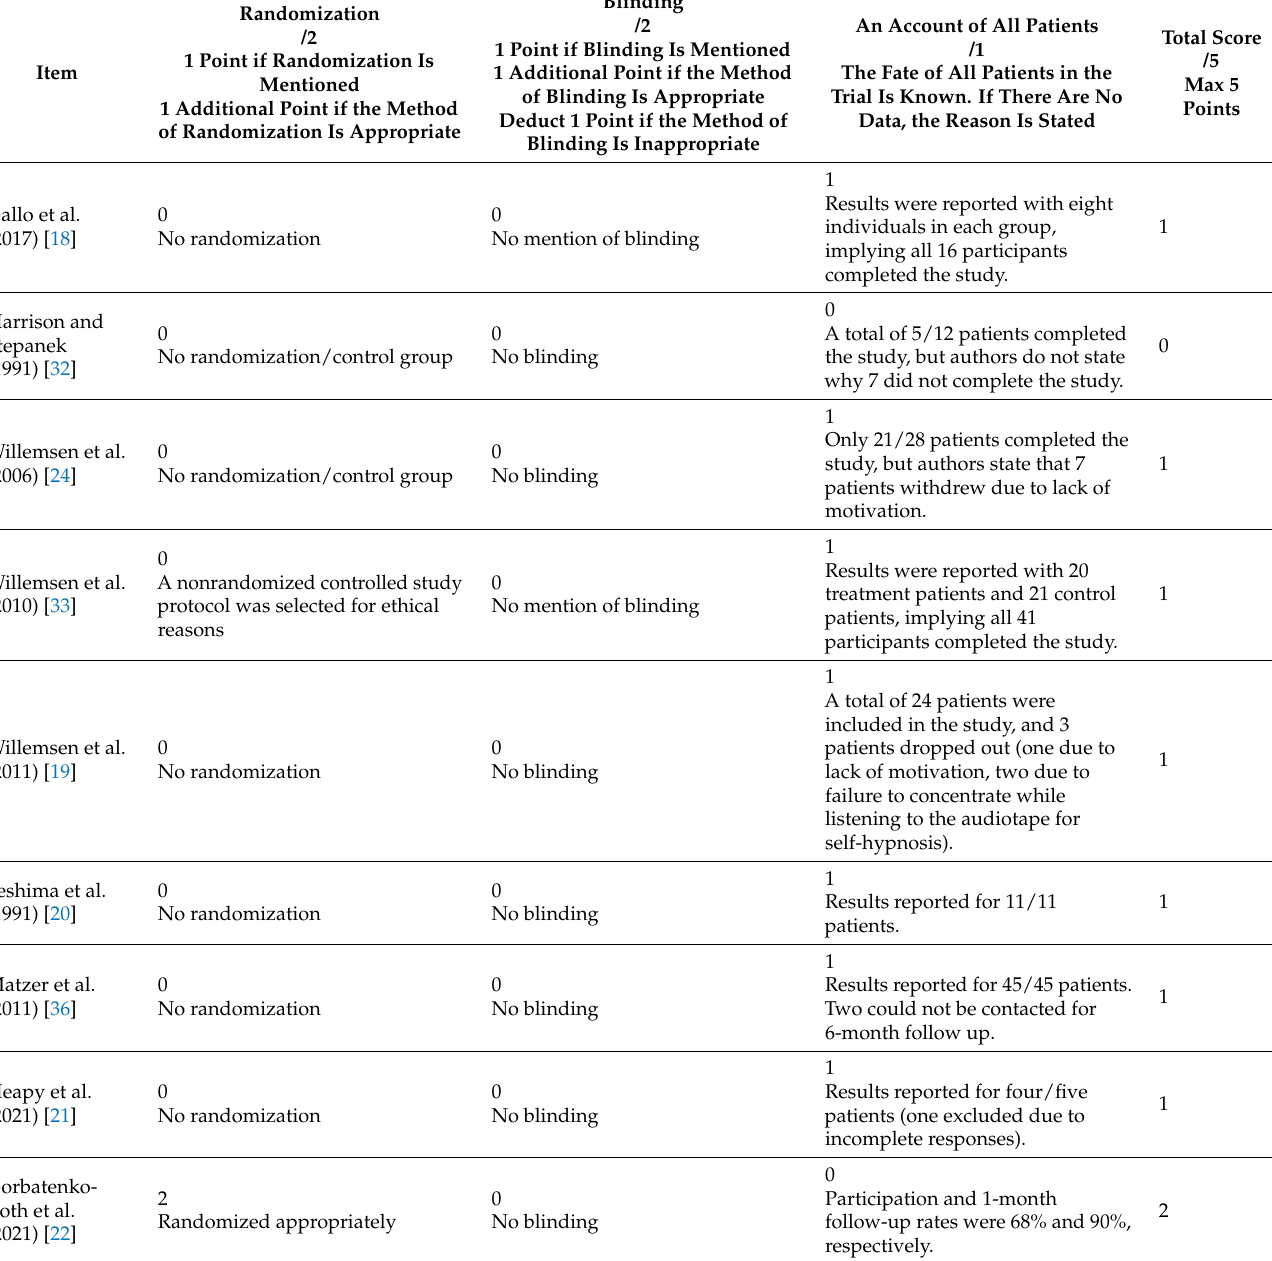
Table 2. Critical analysis of methodological quality using the Jadad